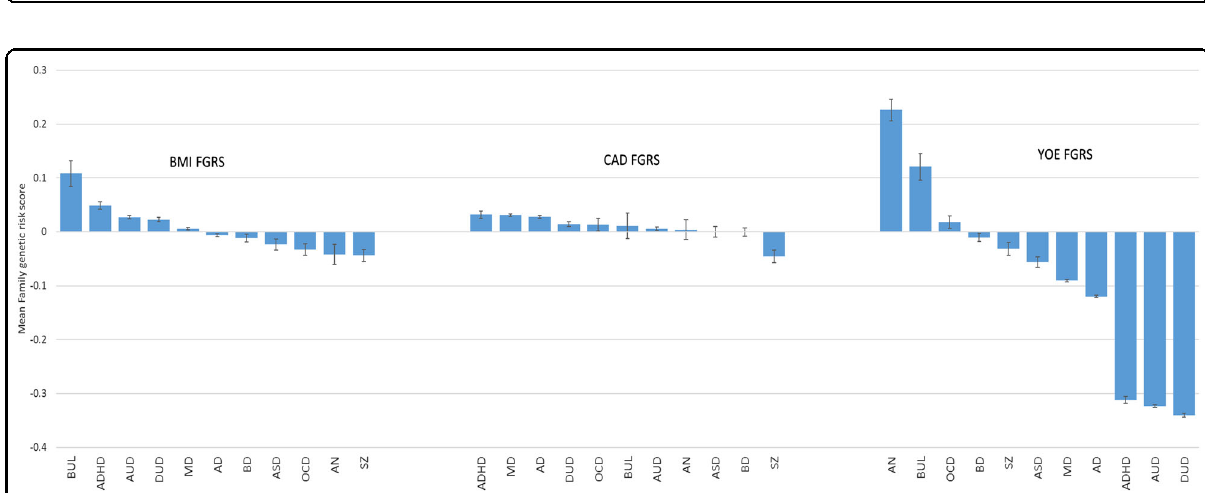
Fig. 2 The mean genetic risk score for 11 disorders in individuals diagnosed with those 11 disorders grouped by genetic risk score. In this fi gure, the individual genetic risk scores are grouped by genetic risk score, from highest to lowest score, not by disorder as in Fig. 1. The y -axis is the mean z -score for the genetic risk scores. For initials of the disorders, see Fig. 1